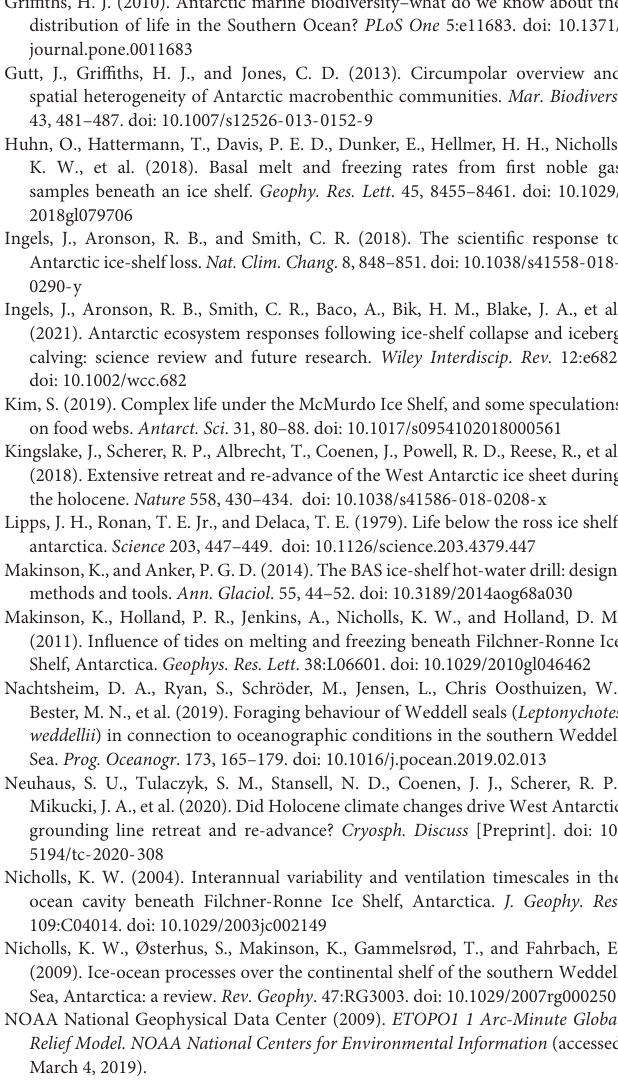
Supplementary Figure 1 | Comparable images of JR275 from open water (seasonal sea ice) sites for comparison with the fauna observed on the boulder. Supplementary Video | Video taken at the seafloor beneath borehole FSW2 in the Weddell Sea beneath the Ronne-Filchner Ice Shelf. Visible in the video are multiple sessile organisms attached to a large